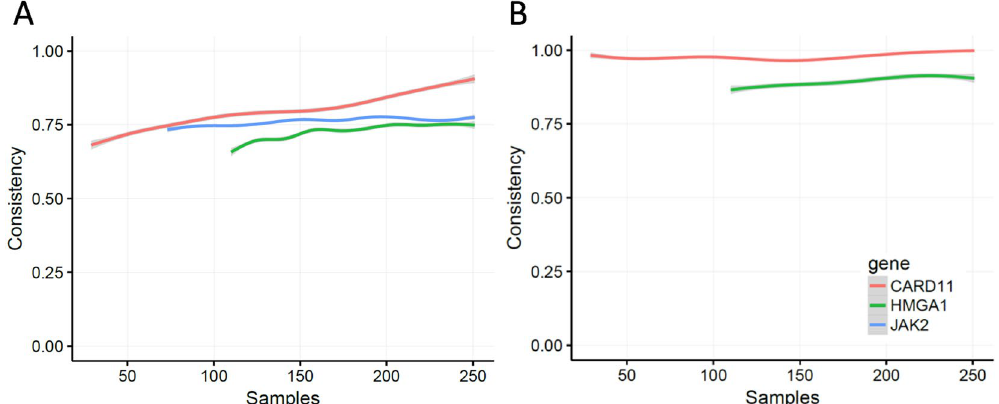
Figure 7. Consistency assessments of regulator selection regarding difference sample sizes of three genes: CARD11 (red, 28 potential regulators), JAK2 (blue, 73), and HMGA1 (green, 109). The lines denote the transition Jaccard’s similarity of the regulators selected at different sample sizes of these genes. ( A ) Consistency of all regulator selection across difference sample sizes. ( B ) Consistency of microRNA regulator selection across difference sample